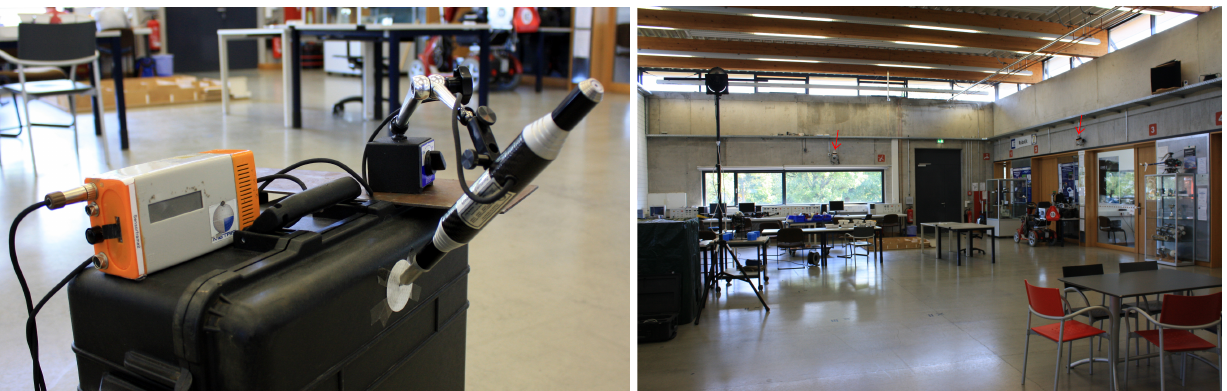
Figure 3. ( Left ): The positions of the reflective markers in the iSpace coordinate system are measured with the hand vector bar. ( Right ): the iSpace transmitters are mounted on the walls of the robotics hall at the University of Würzburg, where the experiments were carried